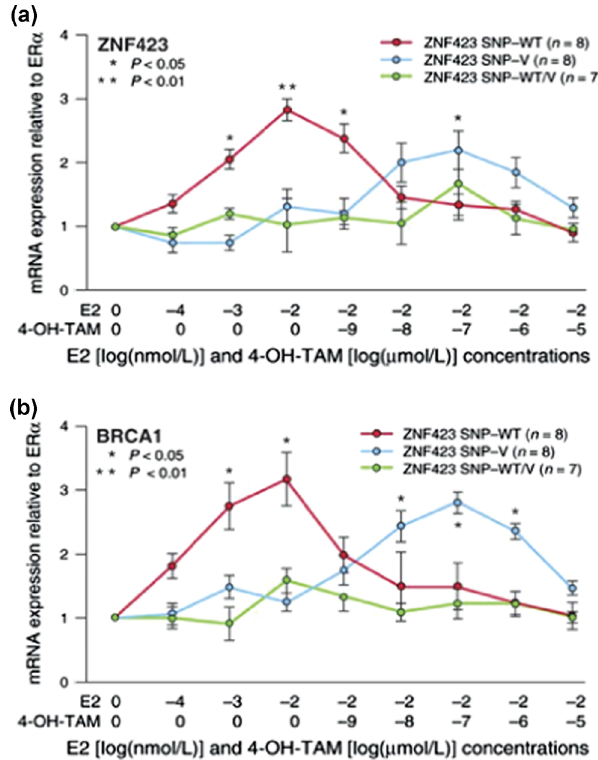
Fig. 1 The SERM-dependent, SNP-dependent “ reversal ” of estradiol induction of ZNF423 and BRCA1 expression in LCLs. a Estradiol (E2) and 4-hydroxytamoxifen (4OH-TAM) dose response curves for expression of ZNF423 ( a ) and BRCA1 ( b ) in LCLs with known genotypes for the ZNF423 intron 2 rs9940645 SNP. Values are mean ± SEM for 8 determinations. (modi fi ed from Fig. 3, Ingle et al.